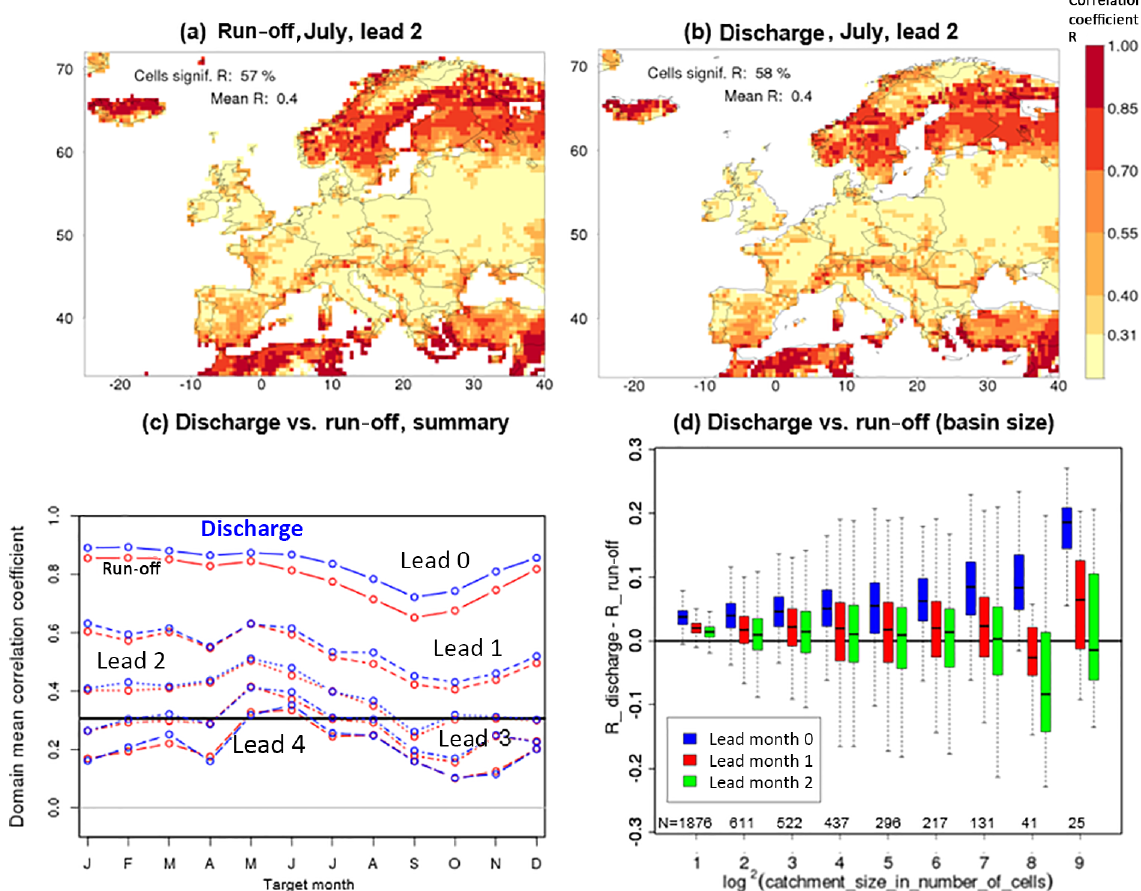
Figure 6. Comparison of the performance of the hindcasts of discharge and run-off using the pseudo-observations for verification. The two maps display R for run-off (a) and discharge (b) for hindcasts initialised on 1 May and target month July (see further explanation in Fig. 1). (c) depicts the annual cycle of the domain-averaged R for run-off (red) and discharge (blue) for lead months 0 to 4. The horizontal line at 0.31 is the threshold of significance for a single cell. (d) is a box plot of the difference between R for discharge and run-off as a function of the basin size. Each bin i contains the results for all basins with a maximum of 2 i cells and more than 2 (i − 1 ) cells; e.g. bin 4 is for all basins with a size from 10 to 16 cells. Boxes represent the interquartile range and the median; whiskers extend to minimum and maximum values found in the bin. All values are average differences over the 12 months of the year and results are shown for three different lead times. The values above the abscissa give the number of cells in each